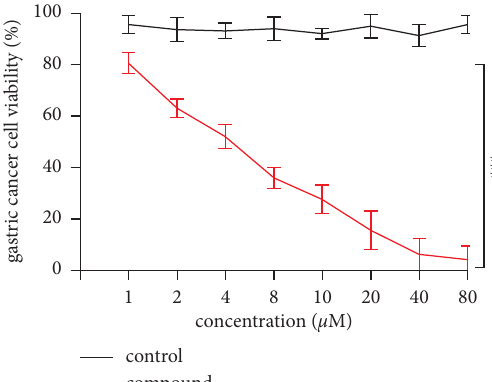
Figure 4: Compound 1 can significantly decrease the viability of gastric cancer cells. The inhibitory activity of the new compounds on gastric cancer cell viability was evaluated by the CCK-8 method. Specifically, gastric cancer cells were inoculated into 96-well plates and treated with the new compound for 2